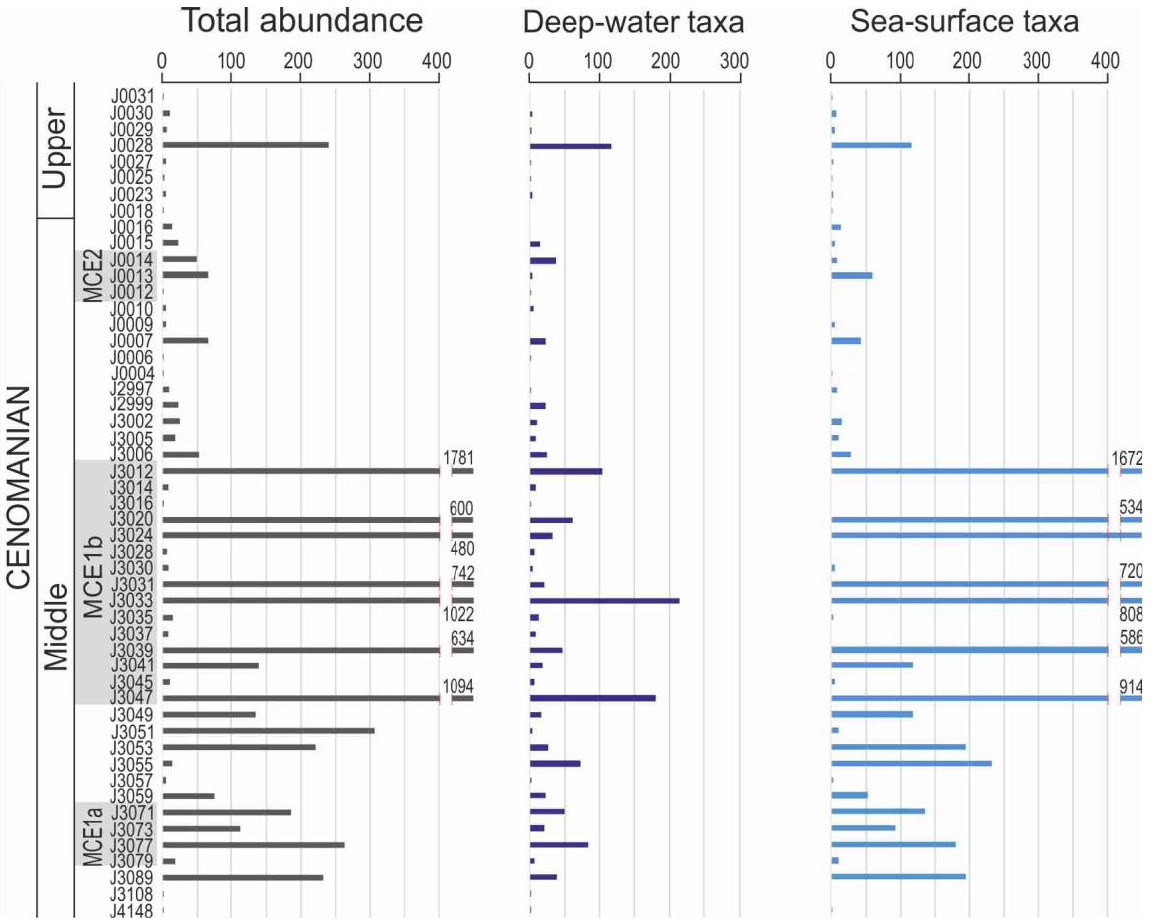
Figure 10. Abundance of two groups of radiolarian taxa, related to depth habitat, interpreted for the middle – upper Cenomanian of the Silesian Nappe, Outer Carpathians.